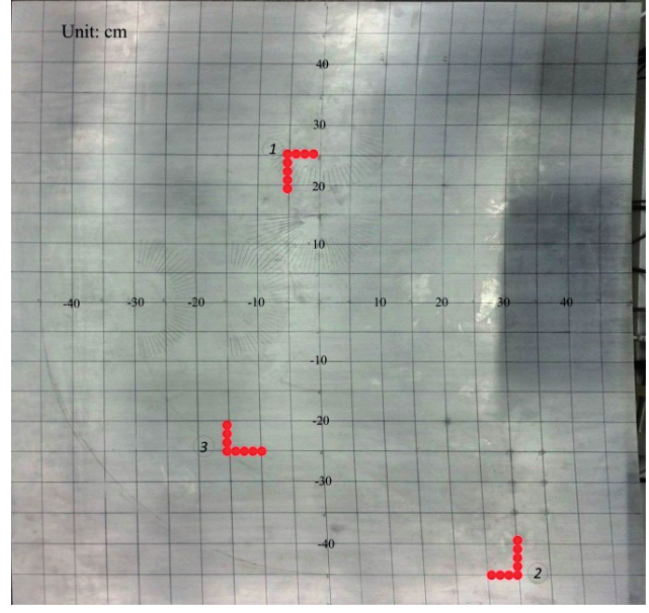
Figure 10. Sensor array positioning.